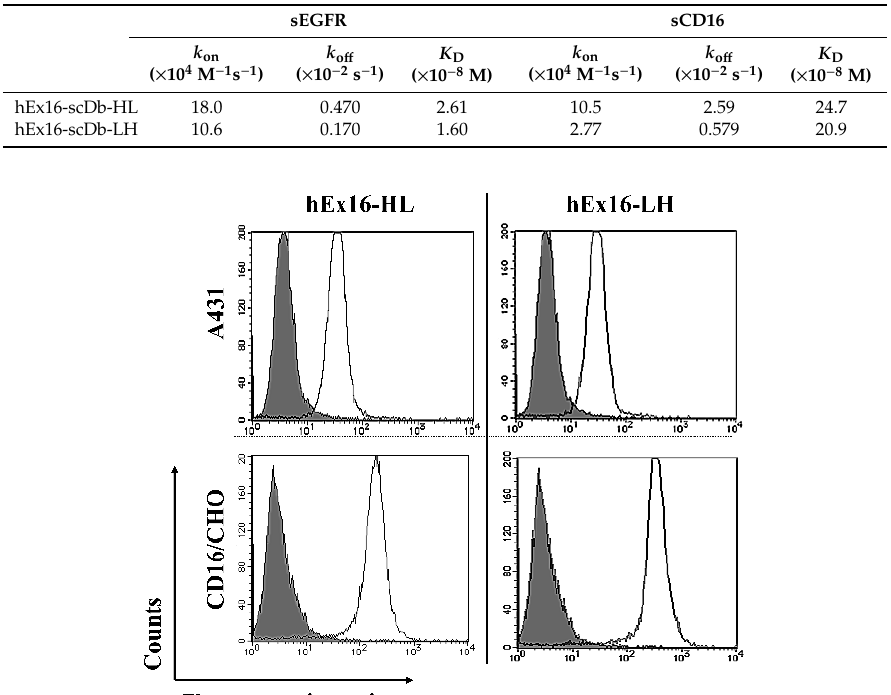
Table 2. Binding parameters of hEx16-scDbs obtained using surface plasmon resonance spectroscopy.